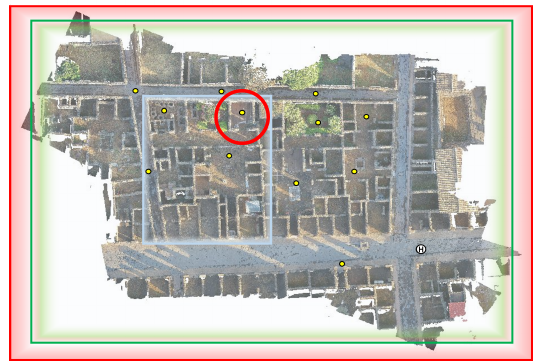
Figure 3. Schema of integrated survey campaign. UAV photogrammetry at 40 m AGL was performed over red areas, UAV photogrammetry at 15 m AGL was conducted over green areas, whereas laser scanning and terrestrial photogrammetry surveyed the light blue areas, respectively. The red circle represents the room where the data processing is